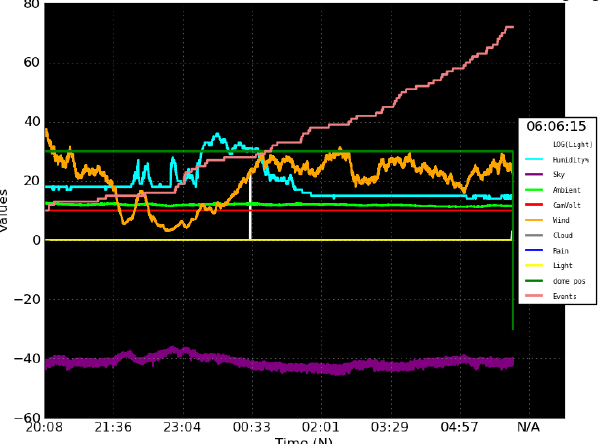
Fig. 7. Screenshot of weather conditions, roof status, and number of detections as sent from CILBO via email at the end of an obser- vation